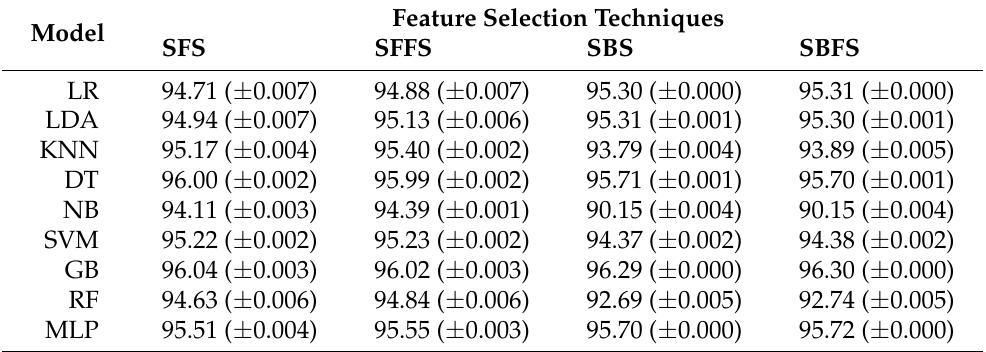
Table 1. Results of F1-score (in %) and the respective standard deviation related to the feature selection techniques for each machine learning